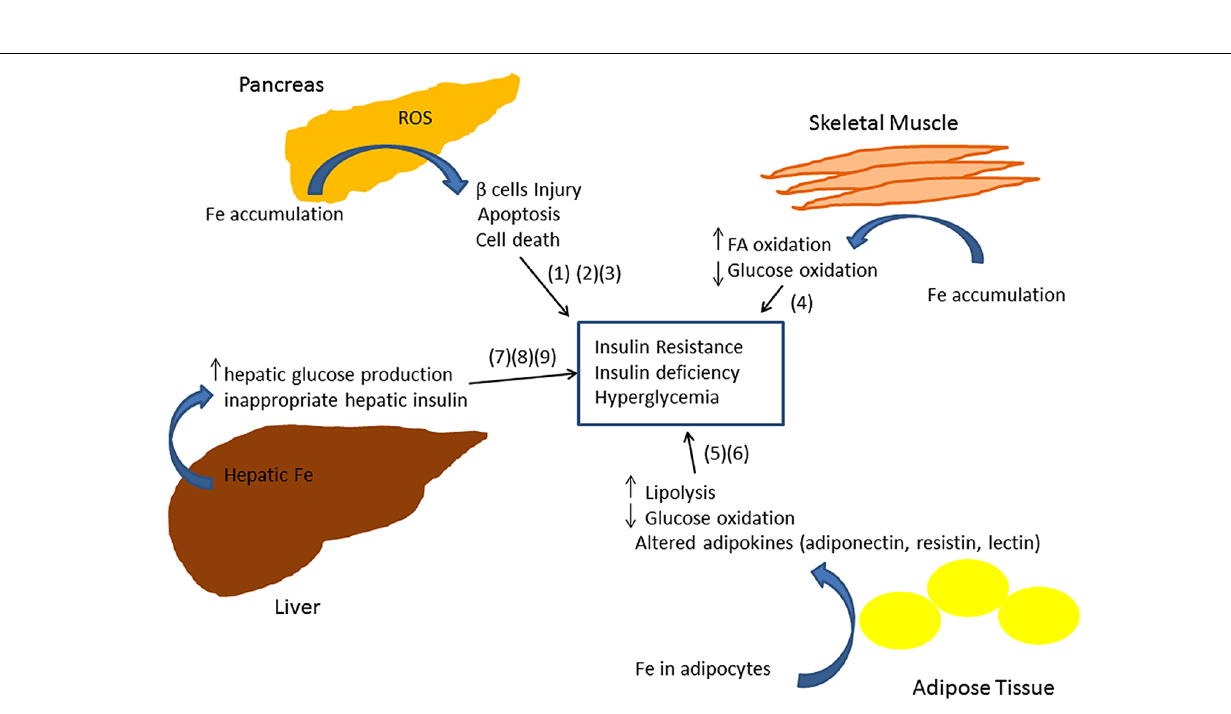
Frontiers in Pharmacology | Drug Metabolism